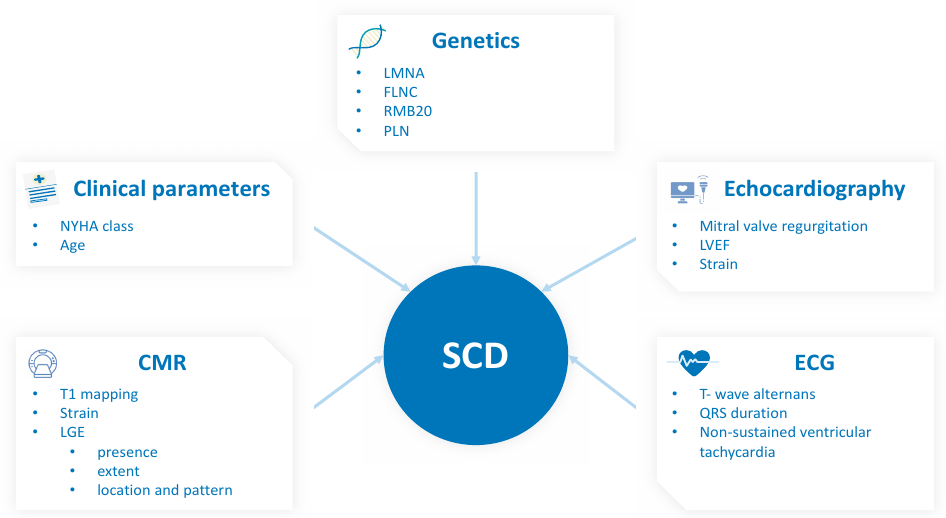
Figure 2. Parameter for risk assessment in patients with non-ischemic cardiomyopathy (NICM). Abbreviations: SCD: sudden cardiac death; CMR: cardiac magnetic resonance; LGE: late gadolinium enhancement; LVEF: left ventricular ejection fraction; NYHA: New York Heart Association.